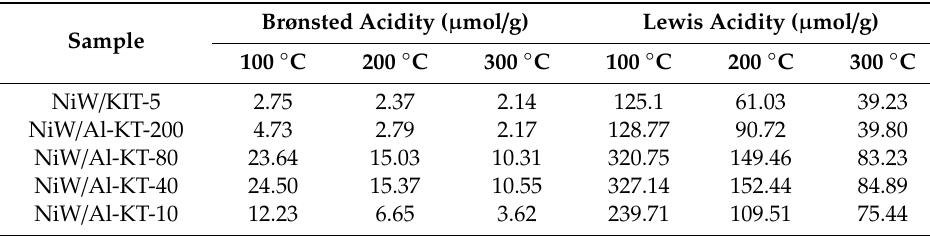
Table 2. Acidity amounts over NiW/Al-KT-X and NiW/KIT-5 catalysts.